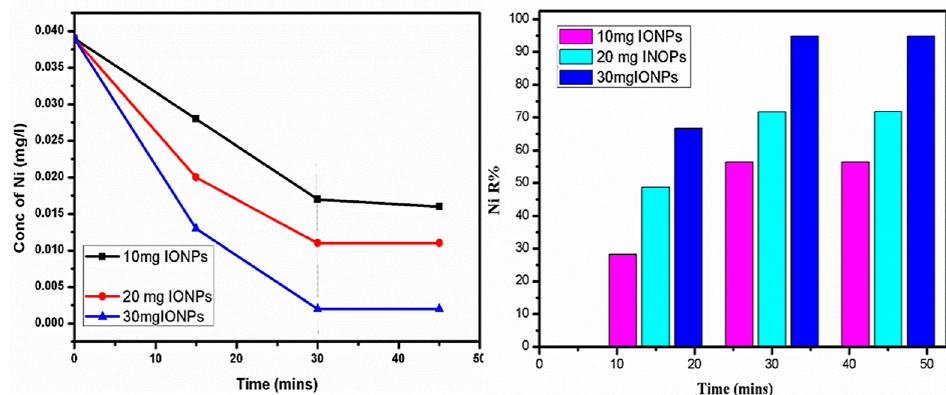
Figure 9. Removal of Ni using IONPs at different concentrations and their removal%.